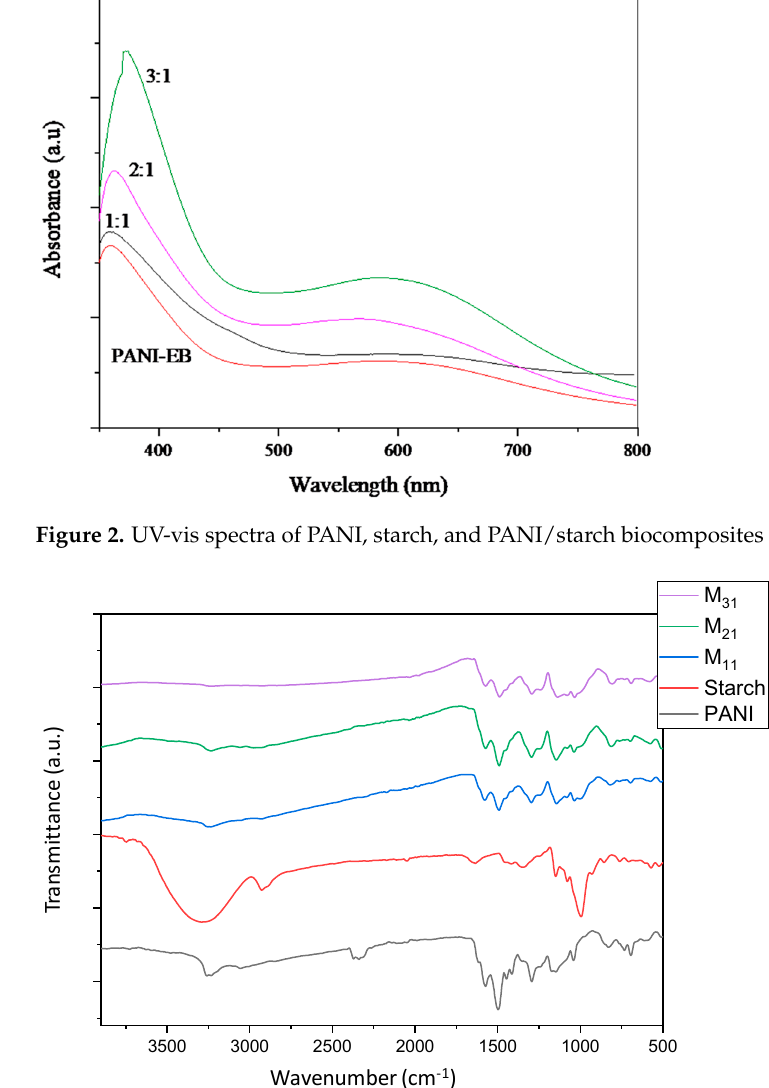
Figure 2. UV-vis spectra of PANI, starch, and PANI/starch biocomposites in DMF.